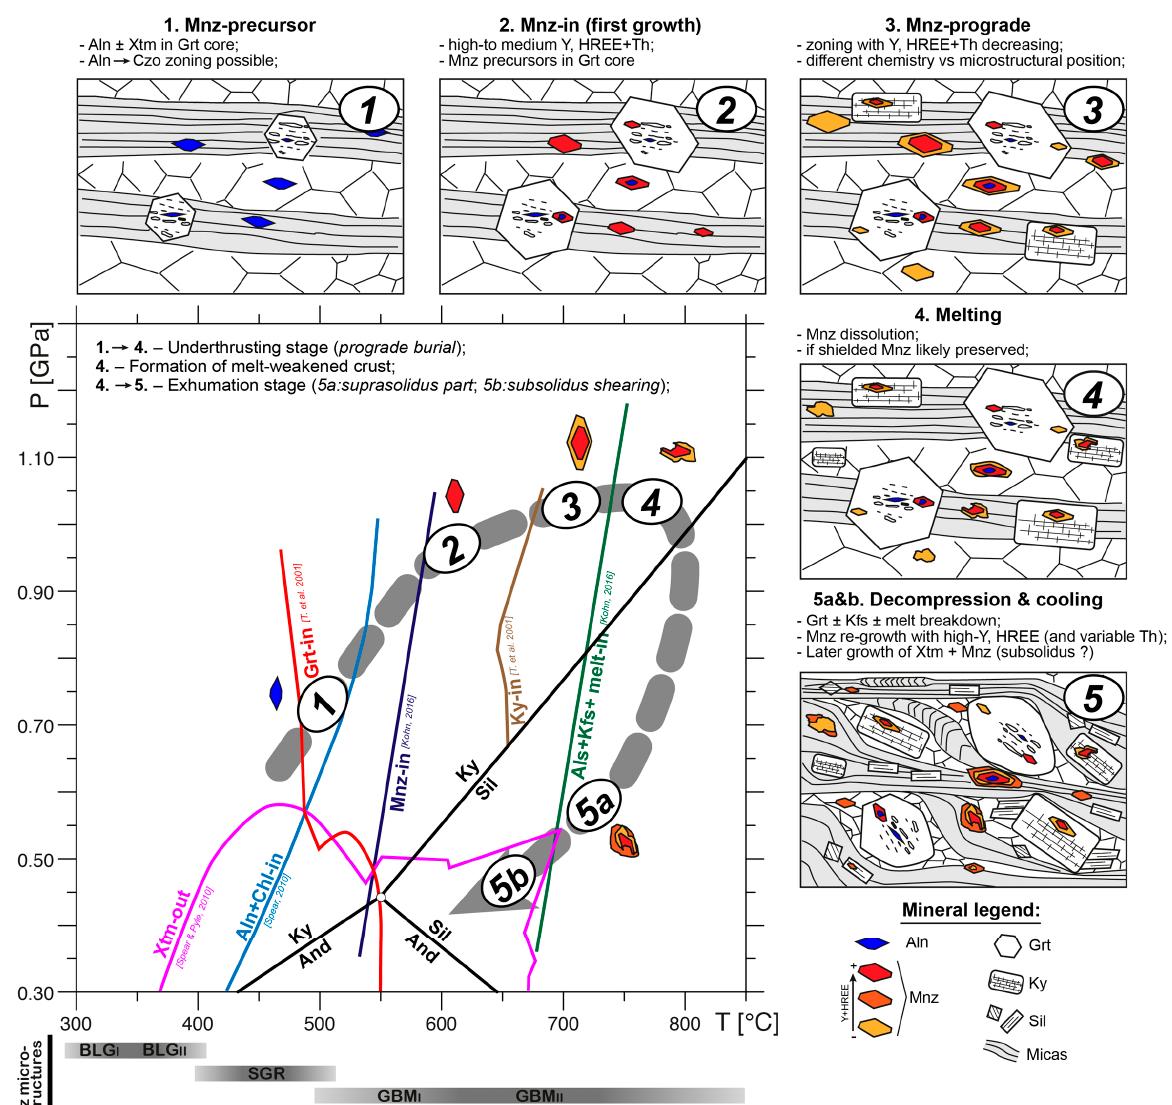
Figure 3. Simplified (and idealized) sketch showing the possible P-T-D evolution of a metamorphic tectonite vs. monazite behavior/zoning. Note that several complexities (e.g., fluids, different bulk compositions) can modify this picture. T range for quartz dynamic recrystallization mechanisms from Law (2014) [34] and Stipp et al. (2002) [35] (BLG—bulging recrystallization; SGR—subgrain rotation recrystallization; GBM—grain boundary migration recrystallization). Mineral-in curves: Als + Kfs + melt-in and Mnz-in = Kohn (2016) [10]; Grt-in and Ky-in = Tinkham et al. (2001) [36] (MnNCKFMASH system); Aln + Chl-in = Spear (2010) [37]; Xtm-out = Spear and Pyle (2010) [32]. Mineral abbreviations as in Whitney and Evans (2010) [38].